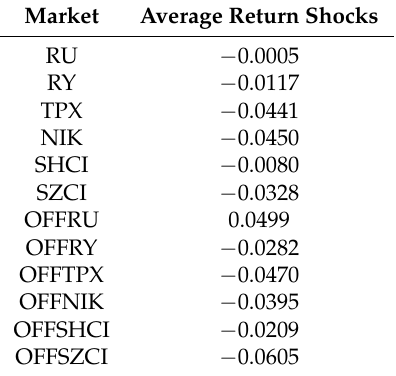
Table 6. Average Market Shock.